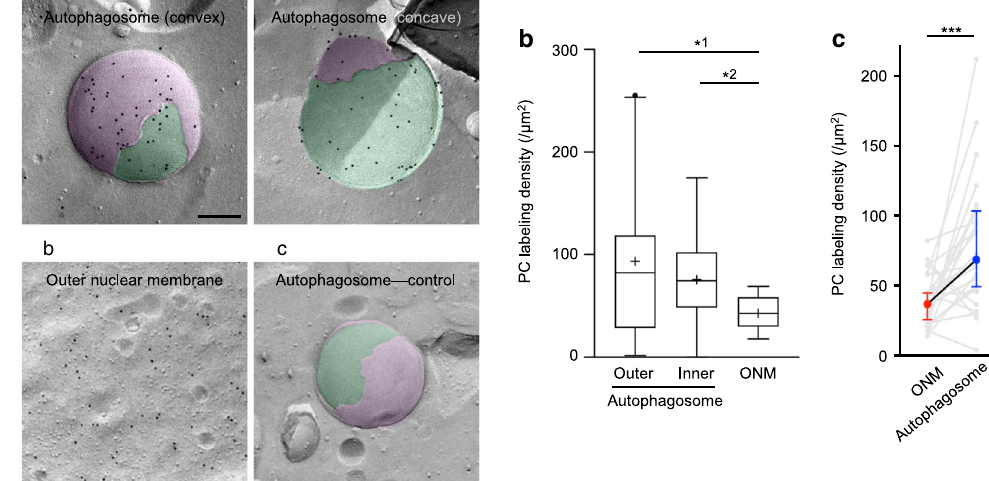
Fig. 2 De novo-synthesized PC observed by freeze-fracture EM. a De novo-synthesized PC labeling. MEFs cultured for 1 h with 0.25 mM propargylcholine in starvation medium were quick-frozen and processed for EM. (a) The convex and concave fracture faces of autophagosome. Cytoplasmic lea fl et (green), non-cytoplasmic lea fl et (pink). See Supplementary Fig. 2B for schematic diagram of autophagosomes in freeze-fracture EM. (b) The cytoplasmic lea fl et of the ONM. (c) A negative control. Copper sulfate was omitted from the click reaction solution. Bar, 0.2 μ m. b PC labeling density. The labels of cytoplasmic and non-cytoplasmic lea fl ets are combined. The center line indicates the median, box boundaries indicate the 25th and 75th percentiles, whiskers are Tukey-type, and the average is marked as + . Pooled data obtained in three independent experiments. * 1 p = 0.0203, * 2 p = 0.0103 (unpaired two-tailed t -test). The total number of areas measured: 49 (autophagosome) and 14 (ONM). The total area measured: 13.11 μ m 2 (autophagosome) and 23.71 μ m 2 (ONM). The labeling density in respective membrane lea fl ets is shown in Supplementary Fig. 2C. c Comparison of PC labeling density in the same cell. Gray lines connect the labeling density in the autophagosome and the ONM in a cell. The medians and the 25th and 75th percentiles are shown by colored circles and error bars. Pooled data obtained in three independent experiments ( n = 23). *** p = 0.0003 (two-tailed Wilcoxon signed-rank test). See Supplementary Fig. 2E for a representative set of micrographs that are used for this analysis. Source data are provided as a Source data fi